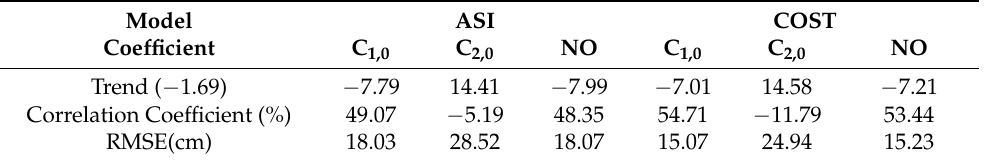
Figure 4. The Swarm-TWSC time series and the long-time trend with different coefficients and GRACE-TWSC’s in Basin 1. The left one is Swarm from ASI and the right one is Swarm from COST. Table 4. The results of Swarm-TWSC of different coefficients compared with GRACE-TWSC in Basin